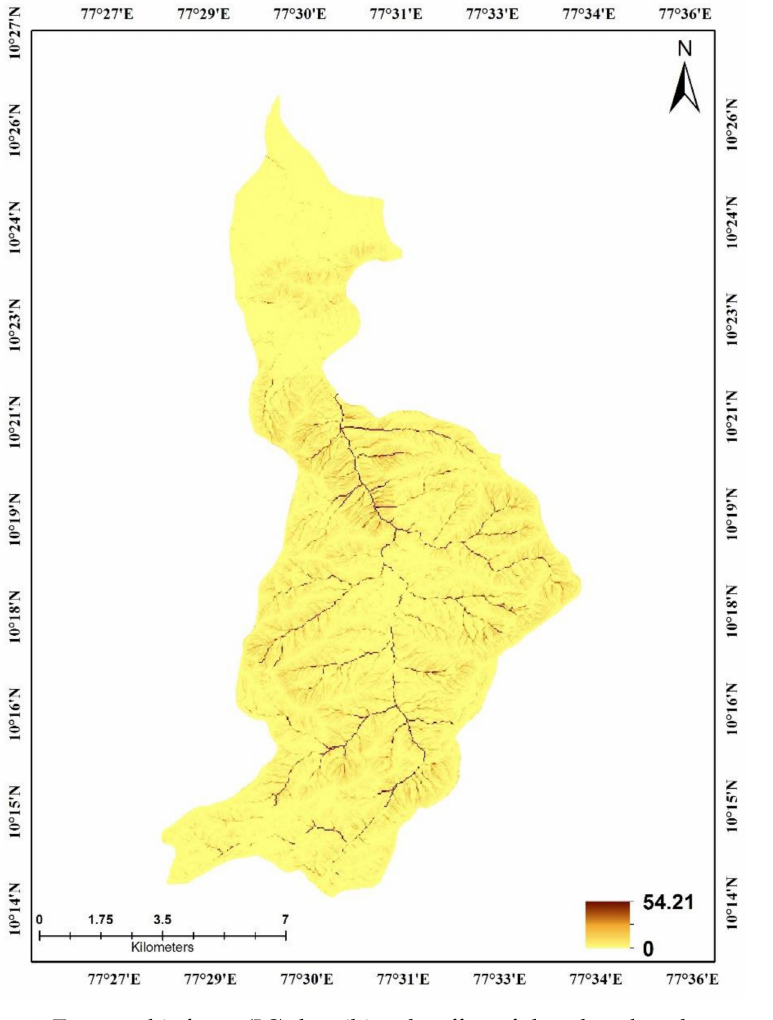
Figure 4. Topographic factor (LS) describing the effect of slope length and